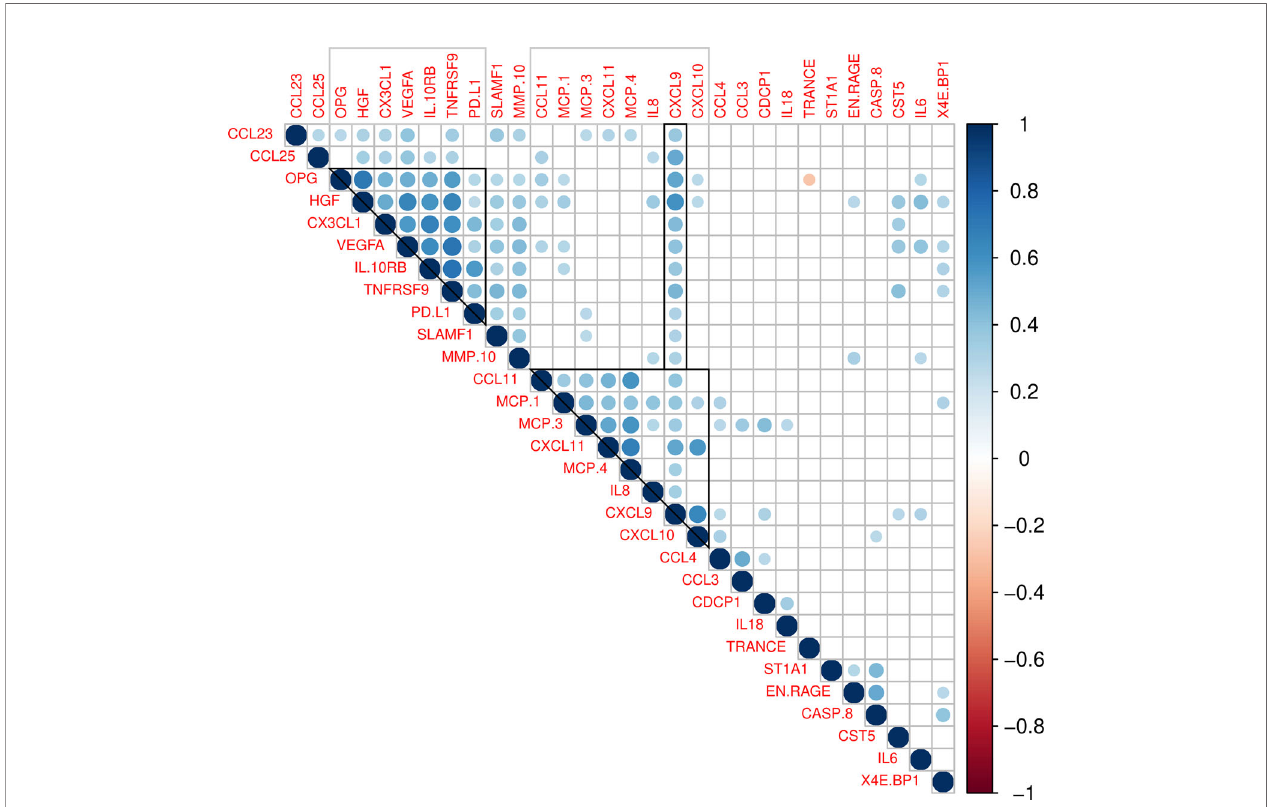
FIGURE 3 | Correlations between plasma levels in 30 proteins showing signi fi cant differences between COPD patients and controls (FDR < 0.05 and log 2 fold change > 0.20). Colored circles indicate a signi fi cant correlation ( P < 0.05). The color scale represents the Pearson correlation coef fi cient (1 positive correlation, -1 negative correlation). Grey squares indicate clusters of correlated